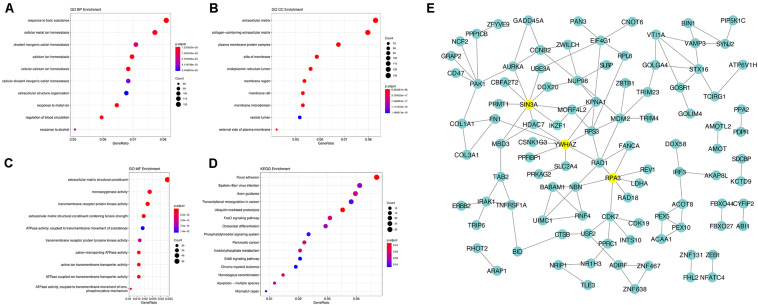
Gene interaction network and functional analysis of OS-associated alternative splicing events in ESCA. (A) biological processes (BP). (B) cellular component (CC). (C) molecular function (MF). (D) KEGG pathway analysis. (E) Gene interaction network of corresponding parent genes of OS-associated AS events generated by Cytoscape.